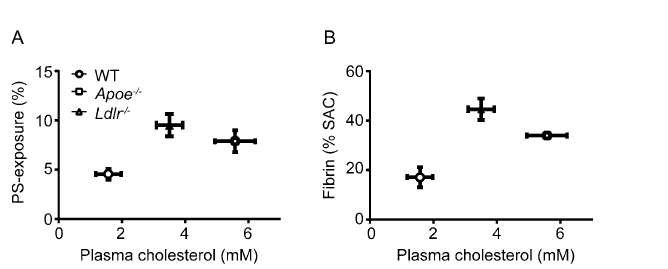
Figure 4. Plasma cholesterol level is associated with platelet phosphatidylserine exposure and platelet-induced fibrin formation. Plasma cholesterol level (Table 1) from wild-type, Apoe −/− and Ldlr −/− mice plotted against: ( A ) exposure of phosphatidylserine (PS) in washed platelets stimulated with 5 mg/ml CRP-XL (see Fig. 1E) and ( B ) surface area coverage (% SAC) of fibrin-covered area from whole blood perfusion over collagen/TF (Fig.